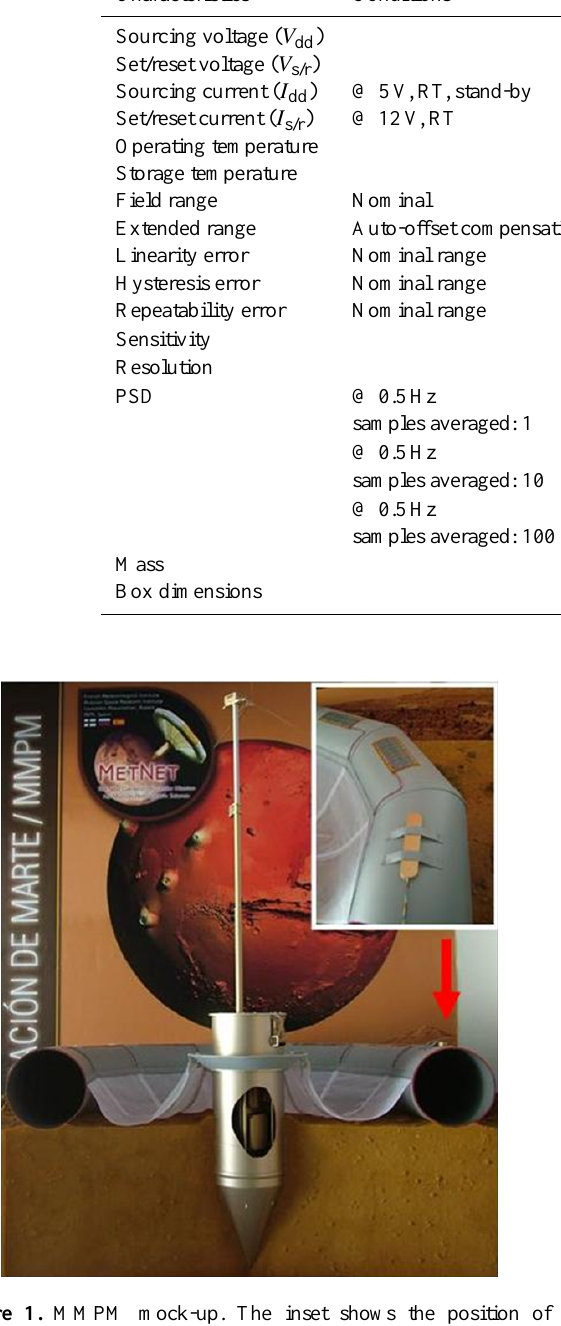
Figure 1. MMPM mock-up. The inset shows the position of MOURA sewn to the inflatable structure of the lander (red